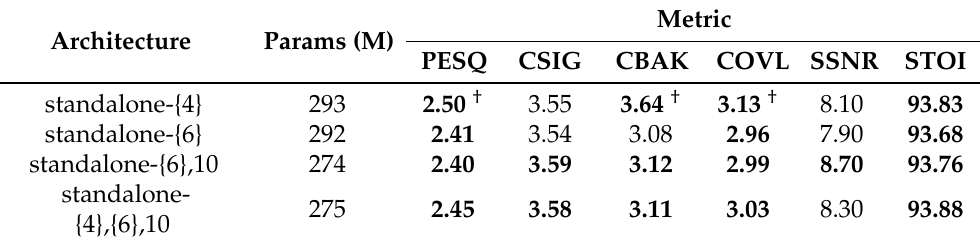
Figure 5. Effects of the window size on the self-attention layers. Table 2. Effects of the locality modeling on the stand-alone self-attention layer. The layer numbers with curly braces represent the employment of locality modeling on the current layer. Values that overtake all baseline systems are in bold. Values with an † are the ones that overtake their best counterparts on the same metric in Table